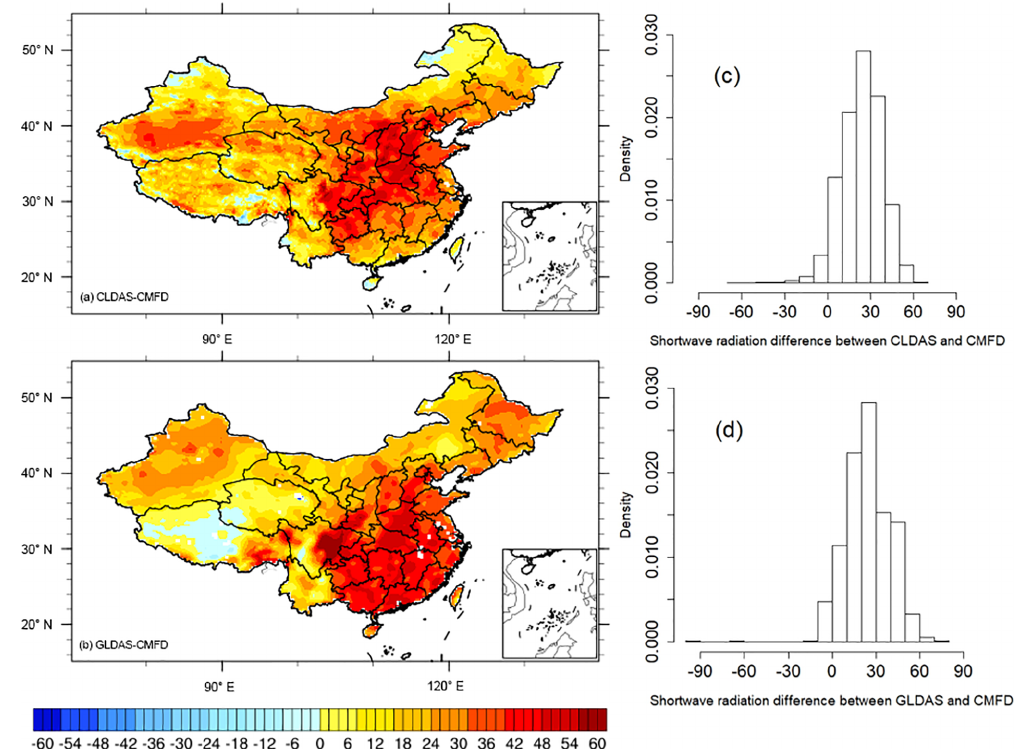
Figure 11. Spatial distributions of differences in mean shortwave radiation between (a) CLDAS and CMFD and (b) GLDAS and CMFD. The corresponding histograms are shown in (c) for CLDAS–CMFD and (d) for GLDAS–CMFD.